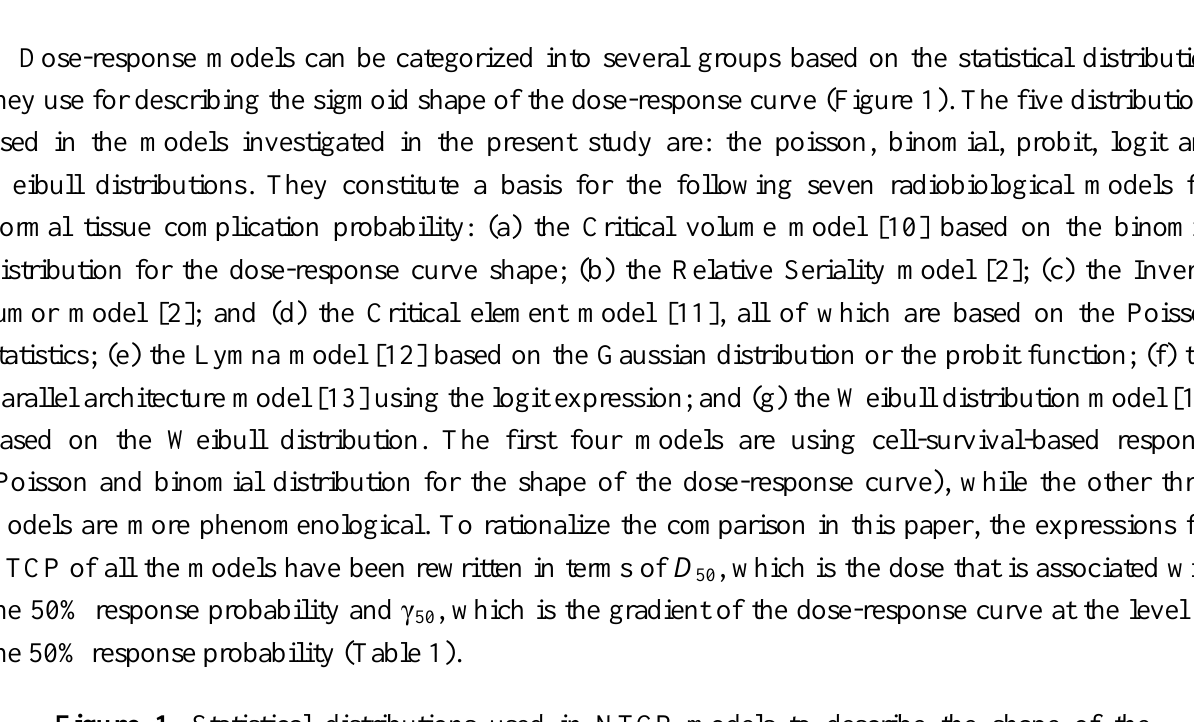
Figure 1. Statistical distributions used in NTCP models to describe the shape of the dose-response